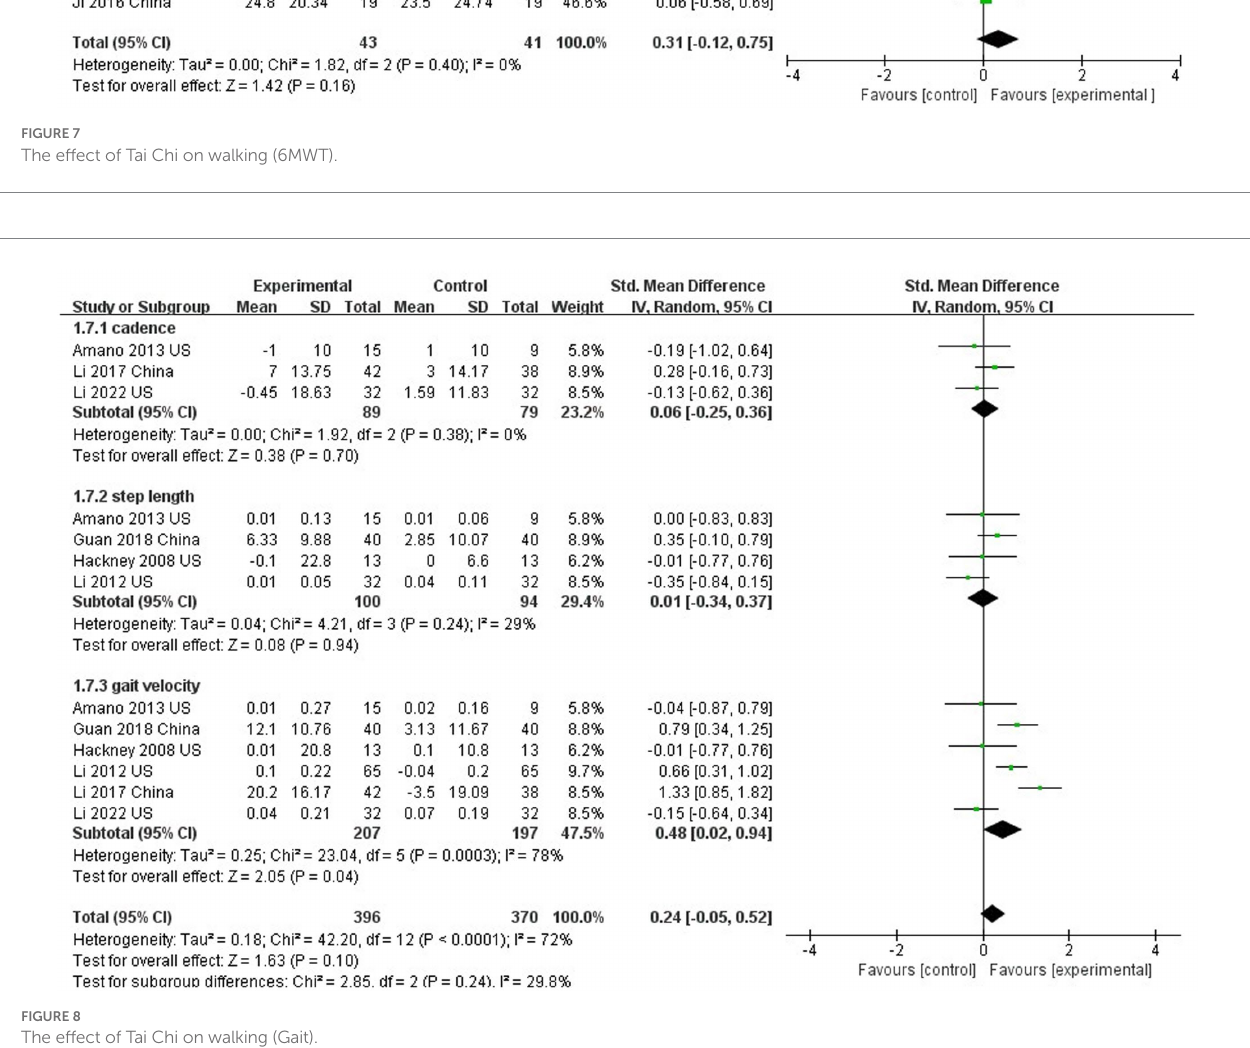
FIGURE 8 The effect of Tai Chi on walking